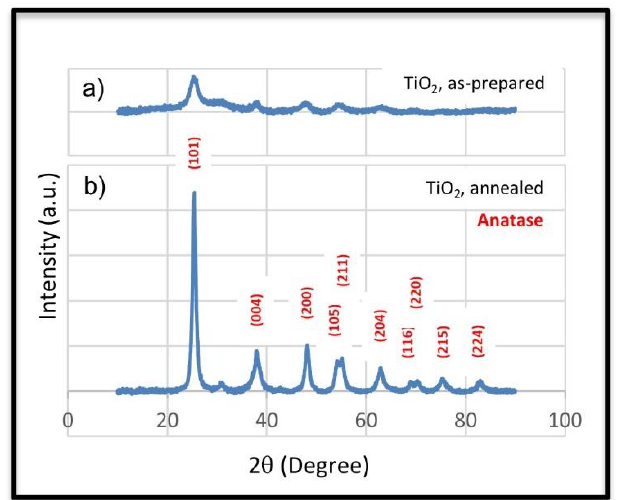
Figure 1. XRD pattern of TiO 2 -10: ( a ) as-prepared, and ( b ) annealed at 300 °C.